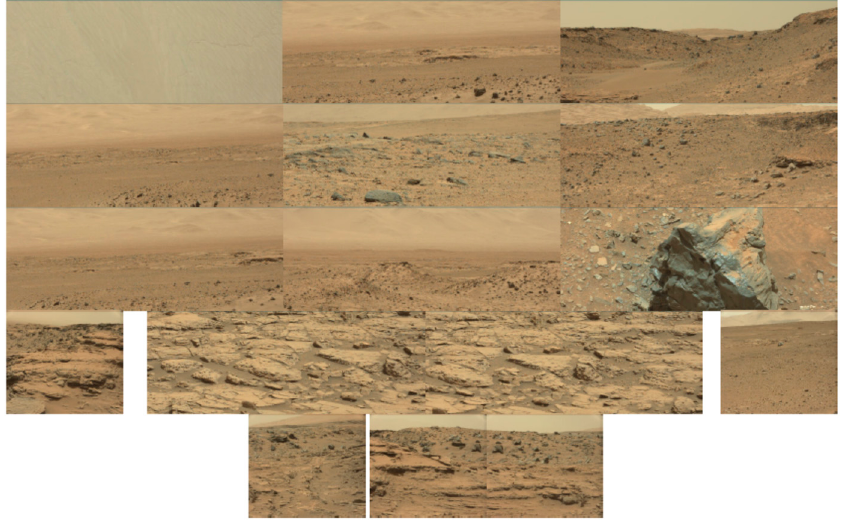
Figure 2. Images from the left Mastcam.